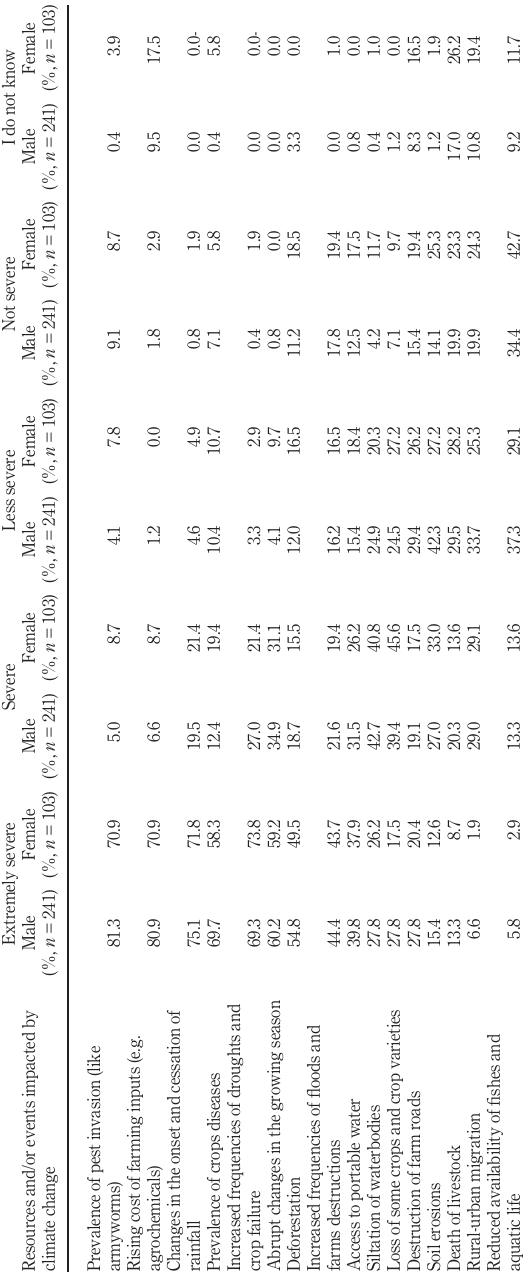
Table 2. The perceived extent of climate change impact on resources and events over the past 20years by